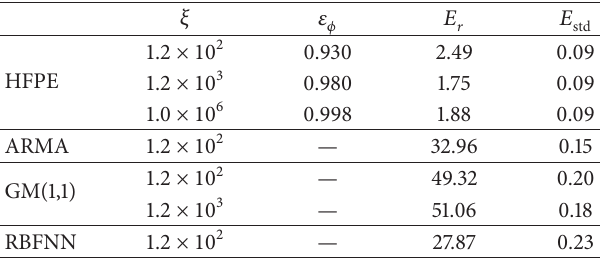
Table 3: Prediction effects of network attack